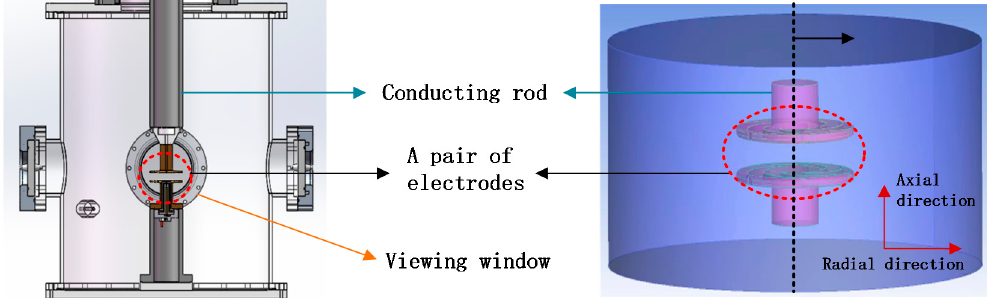
Figure 2. Structural design of the metal tank body of the PJT-GS prototype and the computational domain.